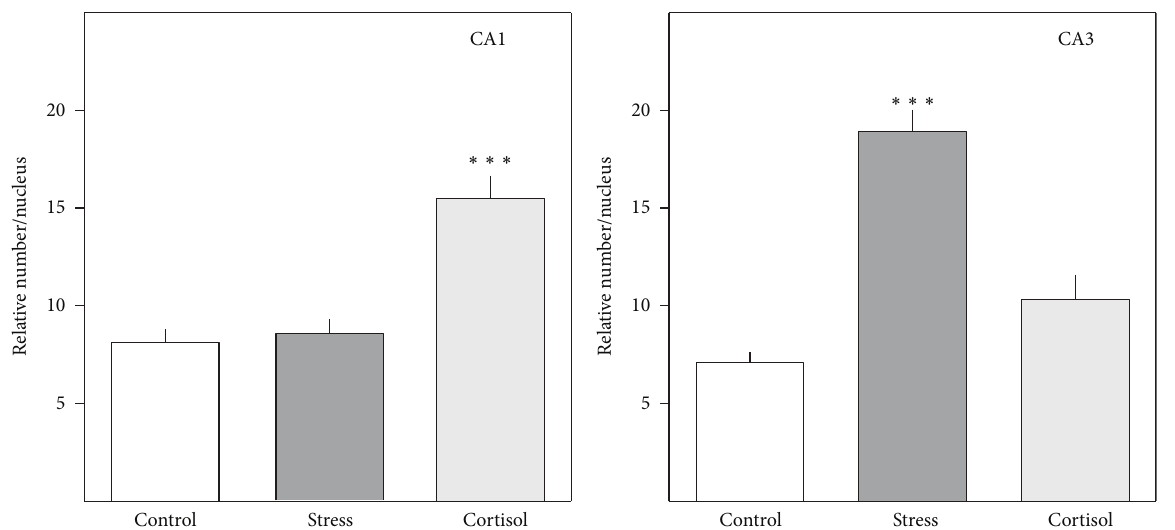
Figure 3: Relative number of heterochromatin clusters in electron micrographs from nuclei of pyramidal cells in CA1 and CA3. Data are mean ± SEM ( 𝑃 ≤ 0.0001